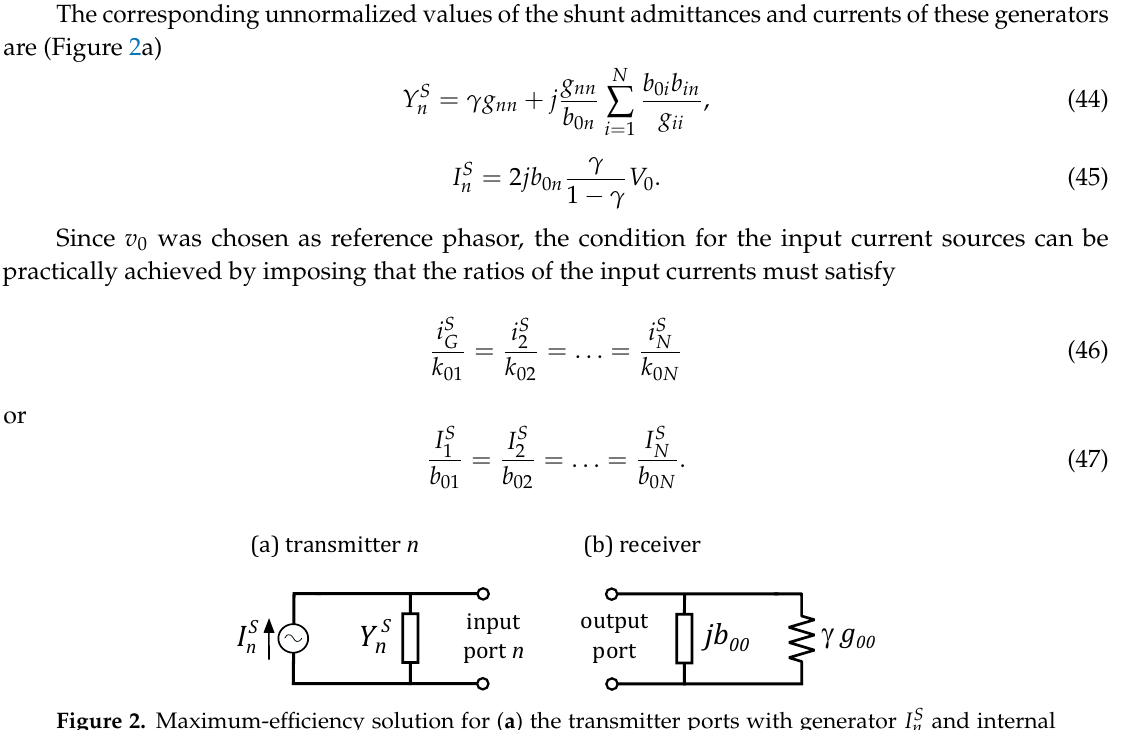
Figure 2. Maximum-efficiency solution for ( a ) the transmitter ports with generator I S n and internal shunt admittance Y S n , and ( b ) the receiver port with the optimal load susceptance and load